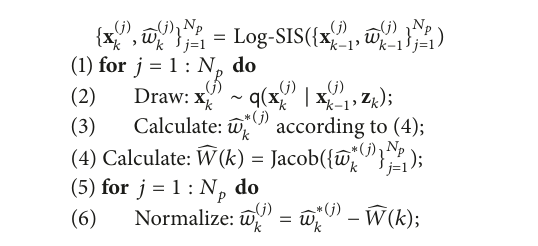
Algorithm 2: SIS-PF in log-domain (SIS